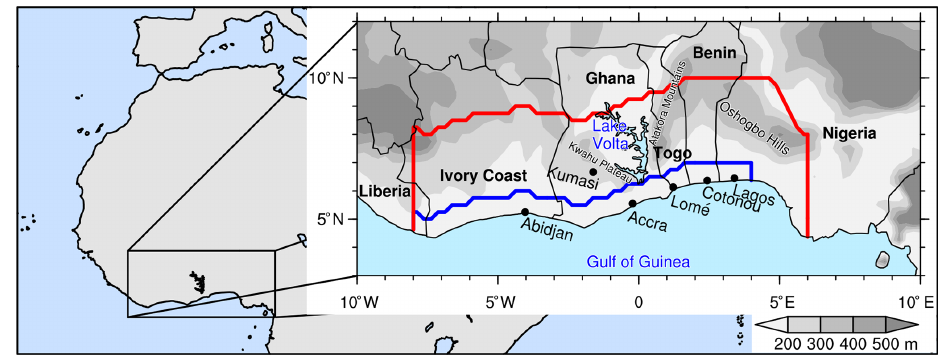
Figure 1. Geographical overview. Map of southern West Africa showing major cities, topographic features, and the areas used for spatial averaging in this paper. The red bordered region is analysed for the little dry season (LDS), while only the blue bordered region, referred to as “coastal strip”, is considered for the second rainy season